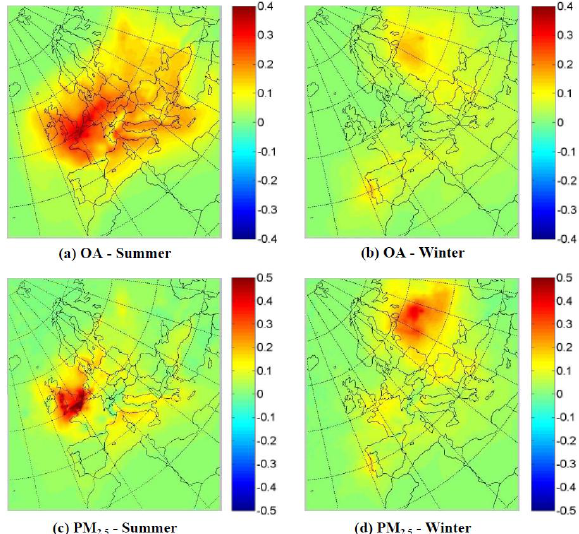
Fig. 7. Predicted reduction (base case – emissions reduction sce- Figure 7. Predicted reduction (base case - emissions reduction scenario) in ground-level 3 nario) in ground-level concentrations (µgm − 3 ) of (a–b) total OA concentrations (μg m -3 ) of (a-b) total OA and (c-d) total PM 2.5 mass after a 50% reduction of 4 and (c–d) total PM 2 . 5 mass after a 50% reduction of anthropogenic anthropogenic VOCs emissions during the modeled summer and the modeled winter period. 5 VOCs emissions during the modeled summer and the modeled win- A positive value corresponds to a decrease. 6 ter period. A positive value corresponds to a